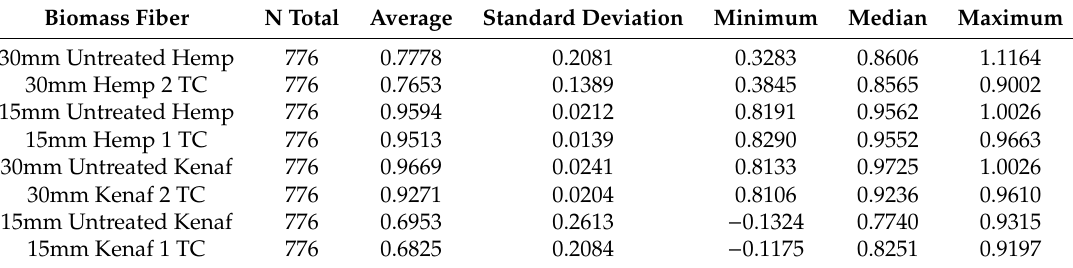
Figure 14. The reflection performances of Hemp and Kenaf. Table 12. Average of reflection coefficients of Hemp and Kenaf.